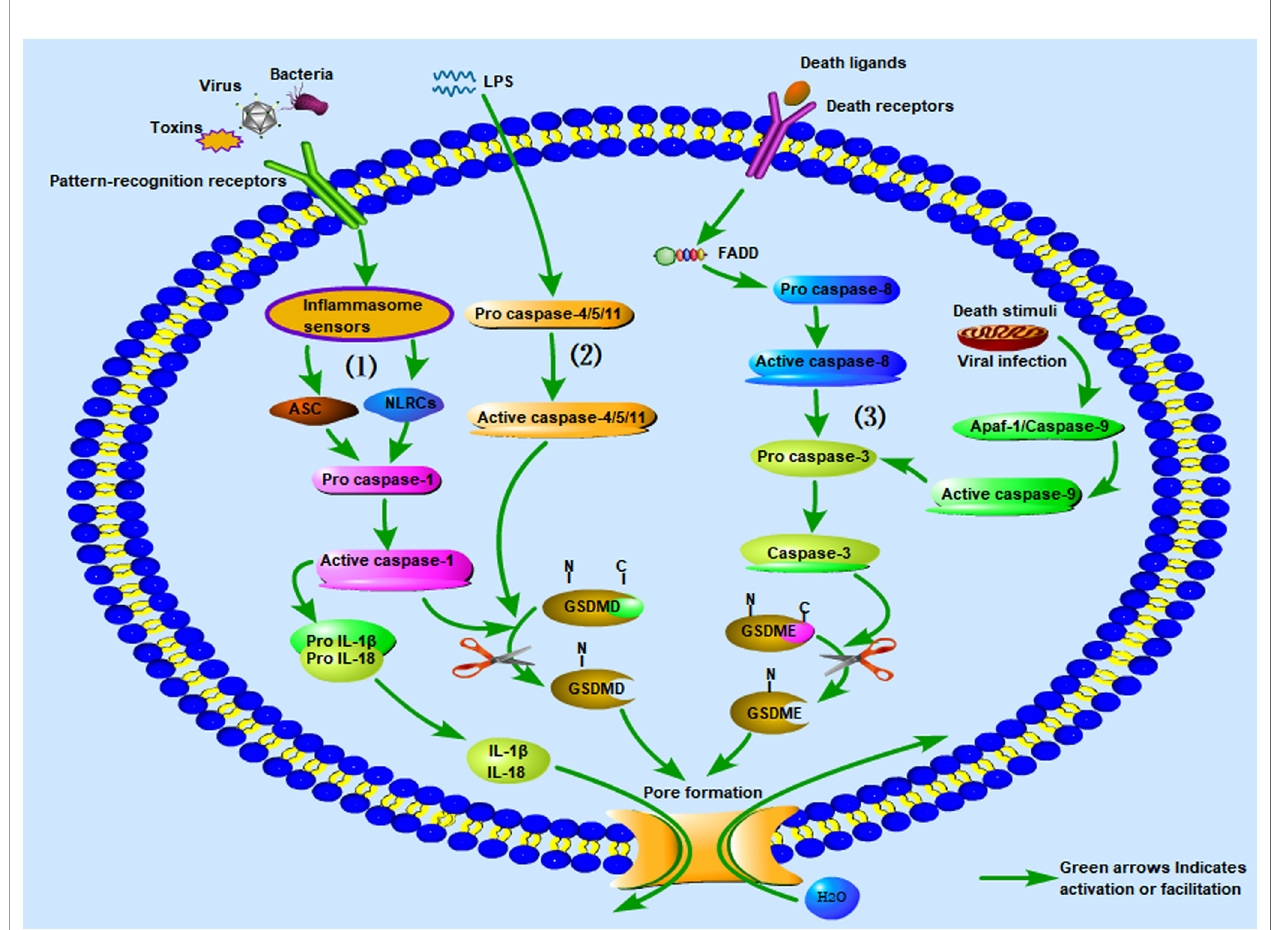
FIGURE 1 | The three kinds of in fl ammasome pathways associated with pyroptosis. (1) Canonical in fl ammasome pathway associated with pyroptosis; (2) non- canonical in fl ammasome pathway associated with pyroptosis; (3) caspase-3 mediated in fl ammasome pathway associated with pyroptosis. LPS,